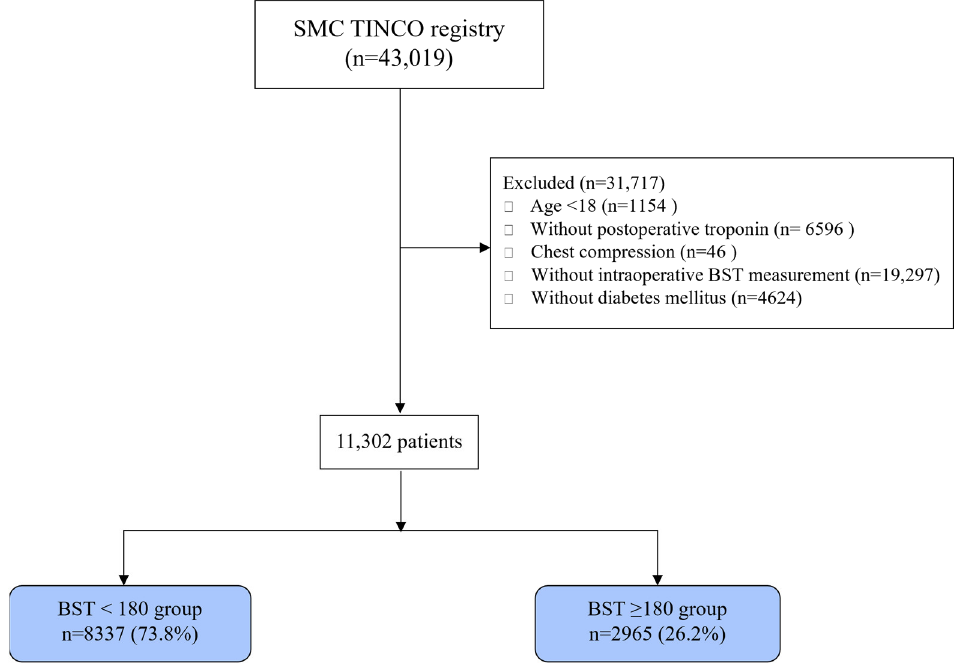
Figure 1. Flowchart of study patients.